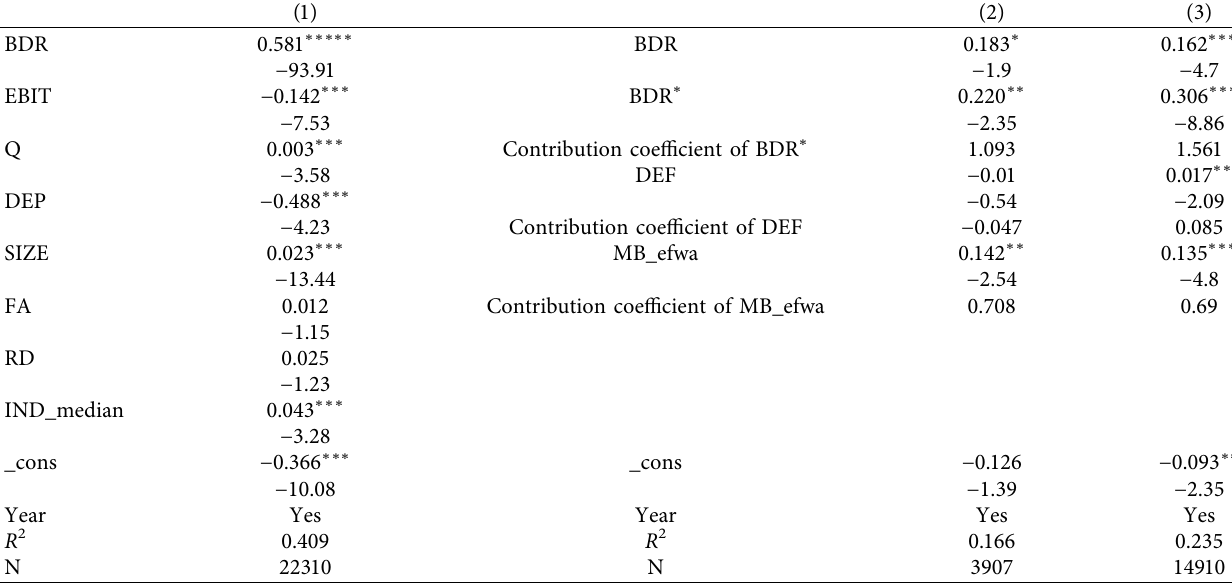
Table 4: The joint moderating mechanism for dividend distribution behavior based on explanations of financing